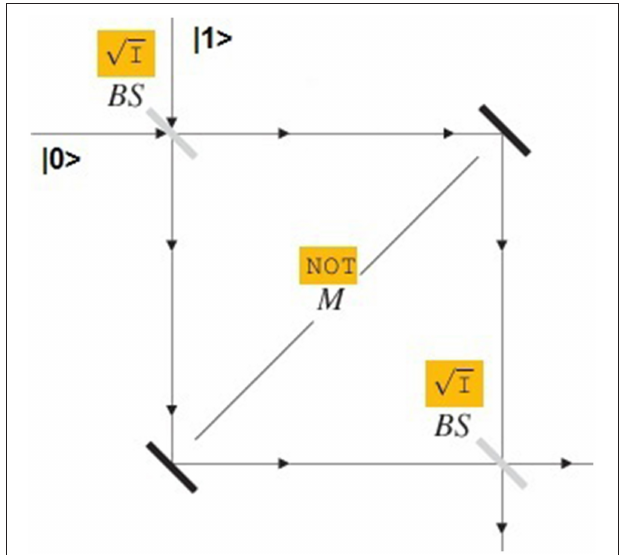
FIGURE 2 | The Mach–Zehnder